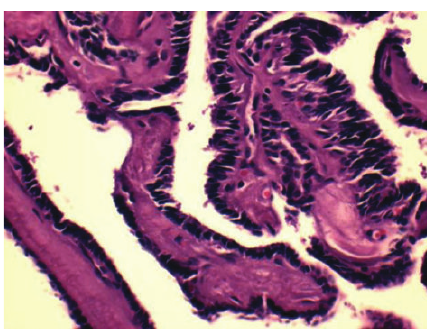
Figure 3: Papillary carcinoma “tall cell” variant evolving from a thyroglossal duct cyst